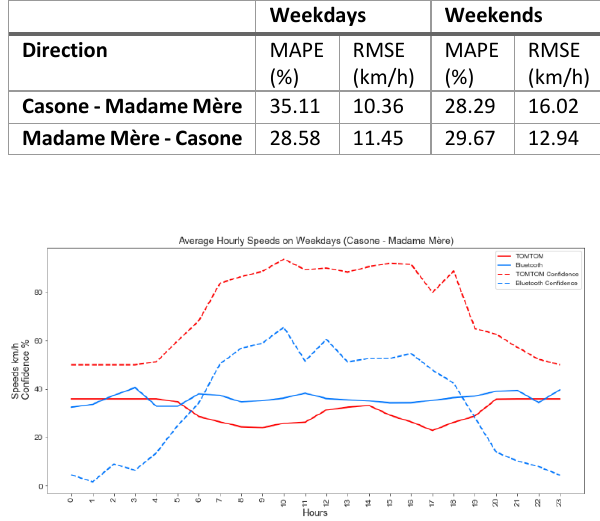
Figure 13: A comparison of TomTom and Bluetooth time-of- day average speeds and the confidence values for traffic driving towards the city centre.